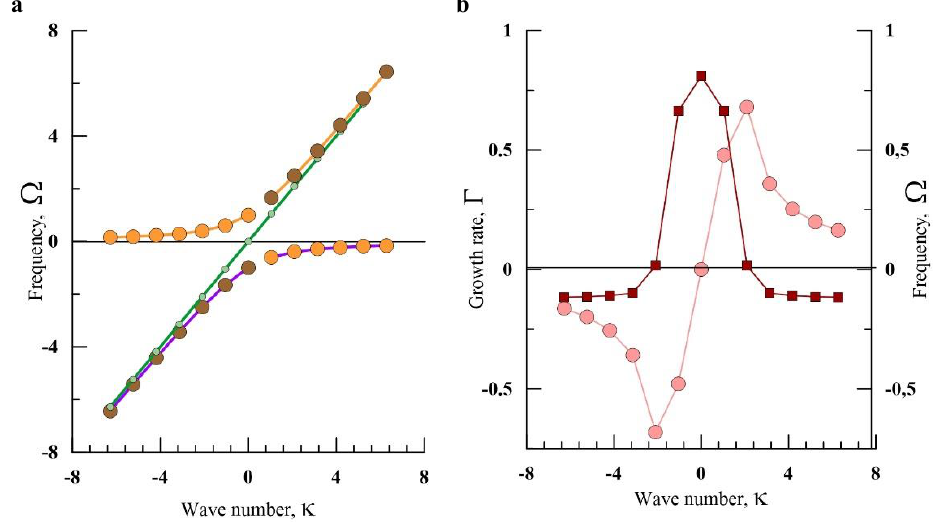
Fig. 3. Dependences of growth rates,  , (squares) and frequencies,  , (curcles) on normalized wavenumbers, k, for hot modes of a pure Fabry-Perot cavity with reflection factor 0.45 R  and length 3 L  . (а) Frequencies of cold modes (solid line with dots) and two branches of decaying hot modes (light curcles are polariton modes, dark curcles are electromagnetic modes) in the presence of an active (absorbing) medium in the ground state, 1 n   . (b) Frequencies (curcles) and growth p rates (squares) of polariton modes in the case of completely inverted active medium, 1 n  , with p small inhomogeneous broadening, 0.1   , and weak relaxation rate of a polarization of active centers, 0.02   . Only five modes are unstable, 0   2